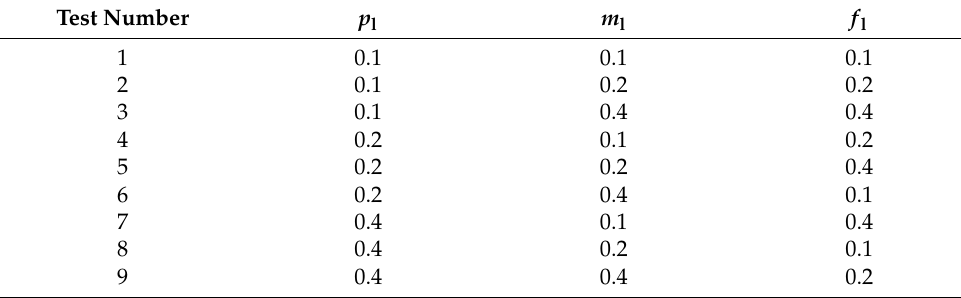
Table 8. Calculation scheme of orthogonal tests under complex